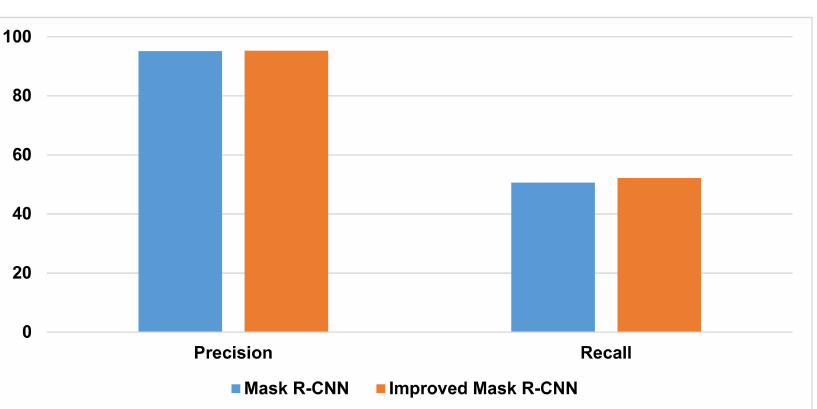
Figure 10. Results of precision and recall for the training dataset for default and improved Mask